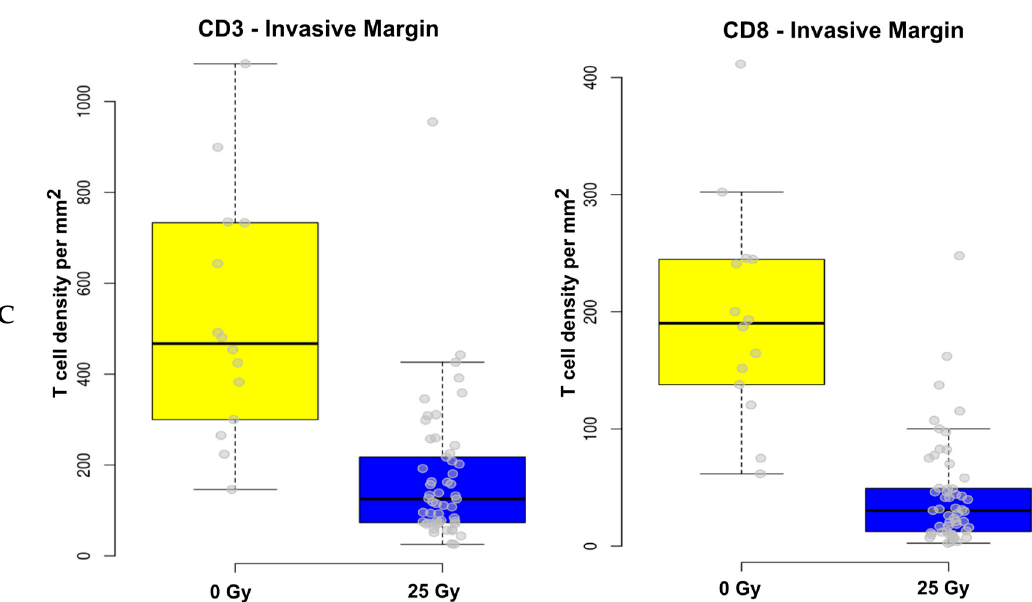
Figure 1. Correlative analysis of T cell density in preoperatively irradiated vs. treatment-naïve rectal cancer specimens quantified by analogue using full tissue sections ( A ) and on virtually established tissue microarray (TMA; ( B ) 2 cores per tumor region and ( C ) 6 cores per tumor region). A. 25 Gy of preoperative irradiation significantly attenuates marginal density of CD8 positive T cells observed on full tissue sections ( p < 0.0001); a trend was shown towards less CD3 density in the IM ( p = 0.0970). B. 25 Gy of preoperative irradiation significantly attenuates marginal density of CD3 as well as CD8 positive T cells seen on virtual TMAs using 2 cores ( p < 0.0001 each). C . 25 Gy of preoperative irradiation significantly attenuates marginal density of CD3 as well as CD8 T cells seen on virtual TMA using 6 cores ( p < 0.0001 each).